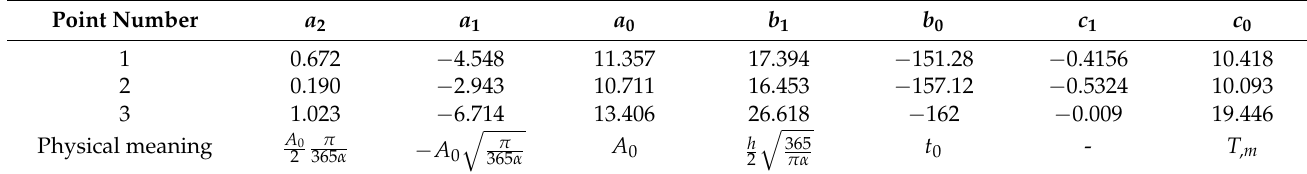
Table 3. Fitting coefficients of Equations (4)-(6) and their physical